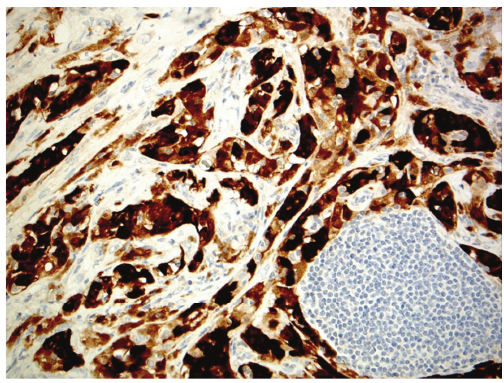
Figure 4: Positive calretinin staining in the neoplastic